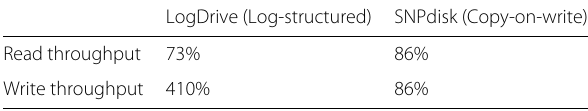
Table 10 Performance comparison with copy-on-write snapshot